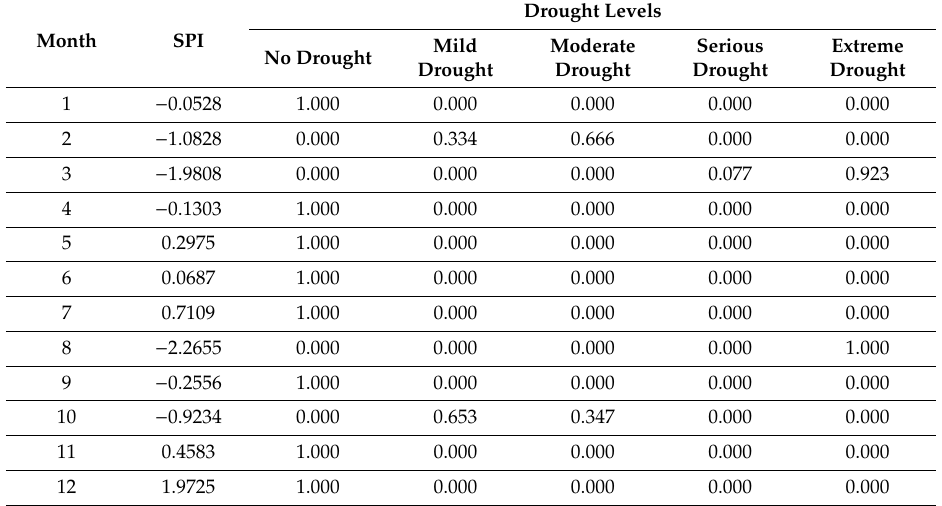
Table 9. Monthly precipitation membership degree for the Jinghui Channel Irrigation Area in 2013.